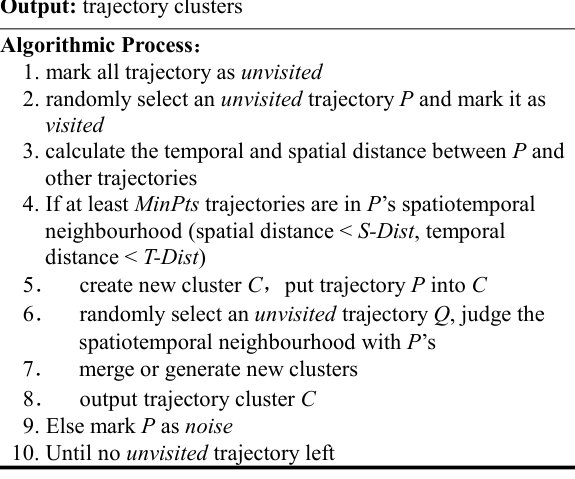
Figure 2. Trajectory spatiotemporal clustering algorithm extended from